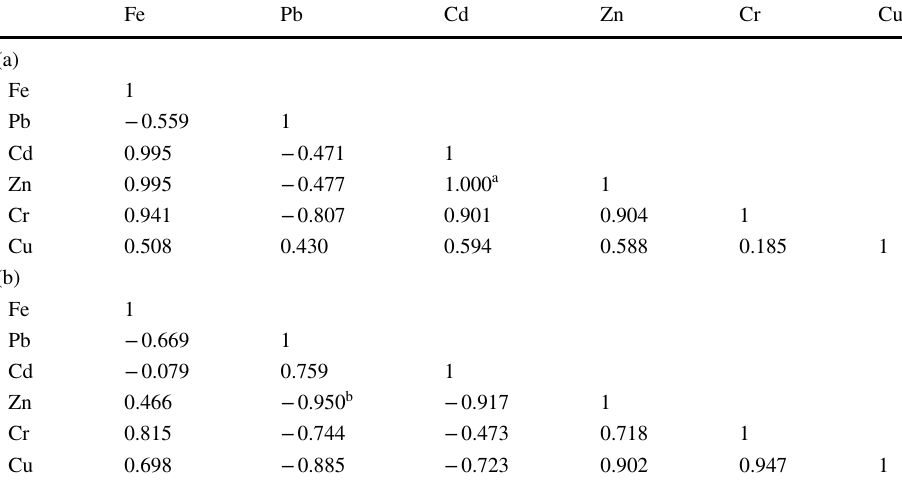
Table 7 Correlation coefficients between the measured parameters of the (a) borehole water samples and (b) well water samples